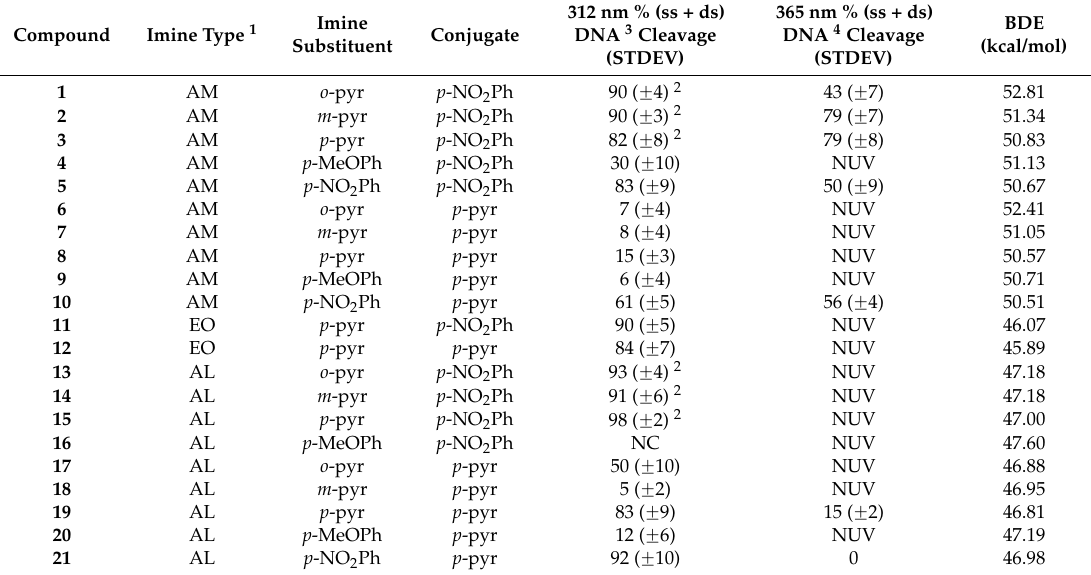
Figure 4. DNA photo-cleavage by various oxime ester conjugates at concentration of 500 µ M with plasmid DNA pBR322, at 365 nm for 120 min. Top: Gel electrophoresis picture: Lane 1: DNA without UV irradiation; Lane 2: DNA with UV irradiation; Lanes 3–9: DNA + oxime derivatives ( 1 , 2 , 3 , 5 , 10 , 21 , and 19 , respectively) + UV irradiation; Bottom: Calculation of the % conversion to ss and ds damage. Table 1. % (ss + ds) DNA photocleavage of amidoxime, ethanone oxime and aldoxime derivatives at 312 and 365 nm.